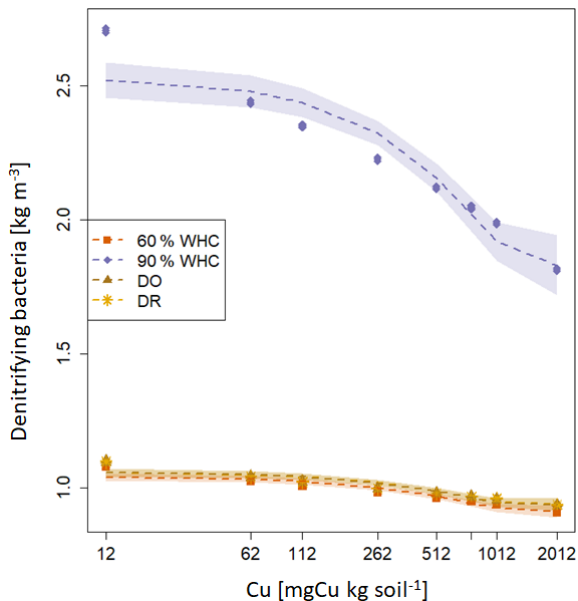
Figure 4. Modelled soil denitrifying bacterial pool after 3d (kgm − 3 soil) for the four moisture treatments. The purple diamond is for 90% WHC, red square for 60% WHC, brown star for Dry-Rewet (DR) and yellow triangle for Dry-Only (DO). Red, brown and yel- low curves are superposed. Pools were modelled for 12, 62, 112, 262, 512, 762, 1012 and 2012mgCukg − 1 of soil as represented by stars. Quadratic fits were used for